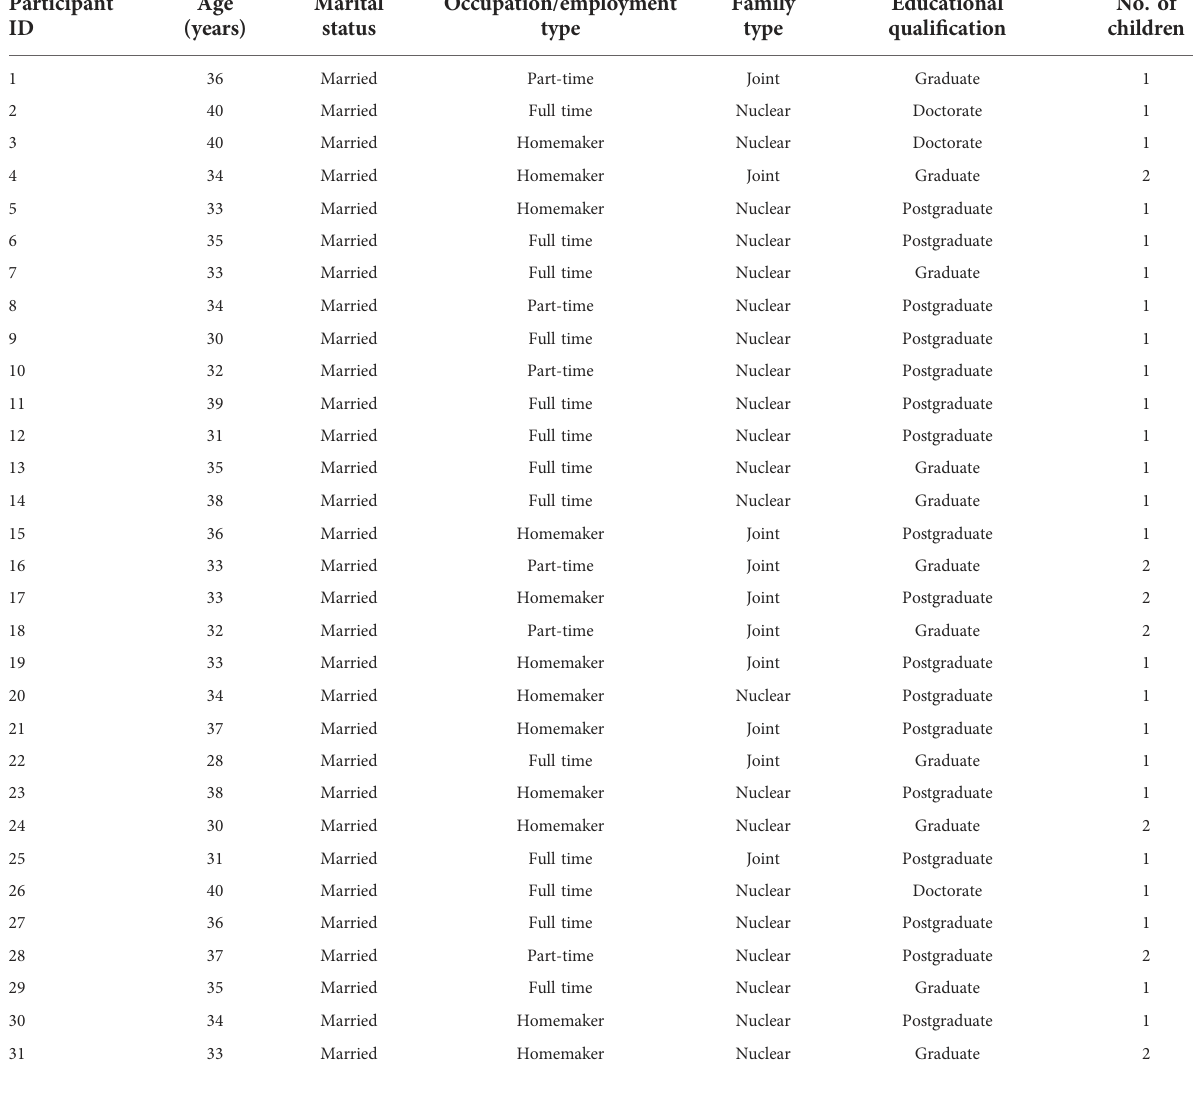
TABLE 1 Sociodemographic information of